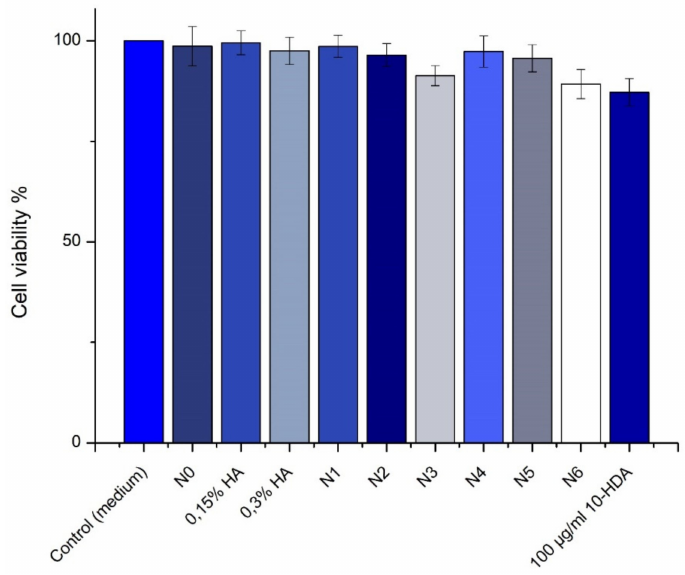
Figure 5. Short-term exposure test on SIRC cell culture line of all microemulsion formulations as well as 10-HDA. The error bars represent the standard deviation of measurements of cell viability ( n = 5).